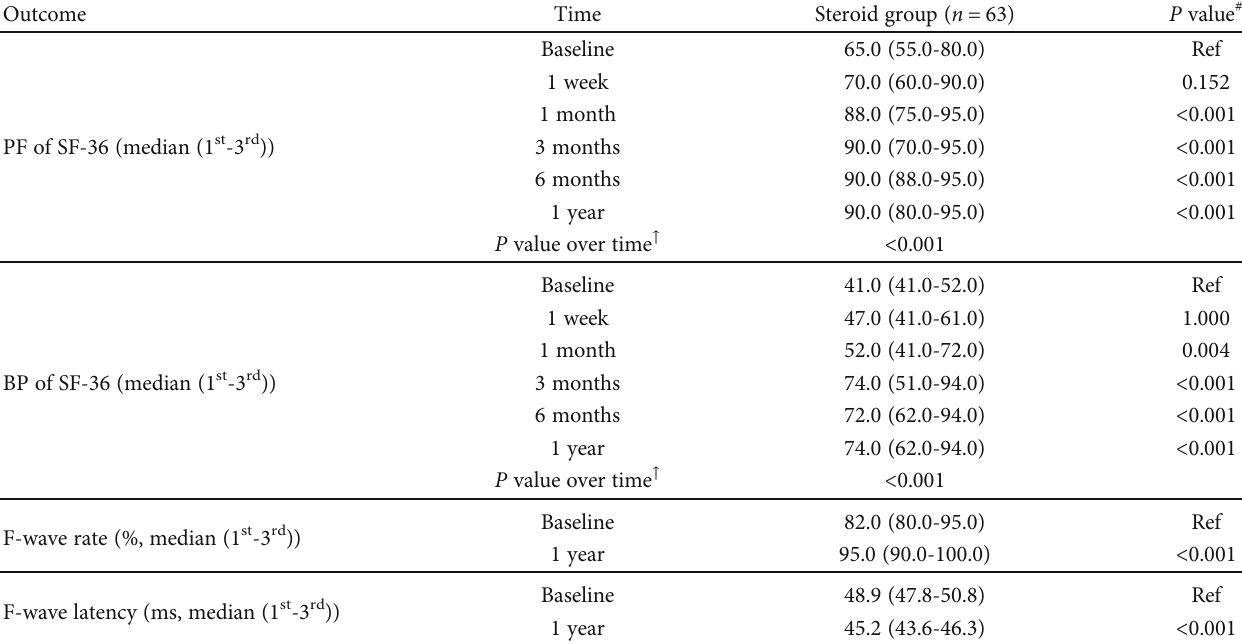
Table 5: Longitudinal outcomes of life quality and nerve function for the steroid group over